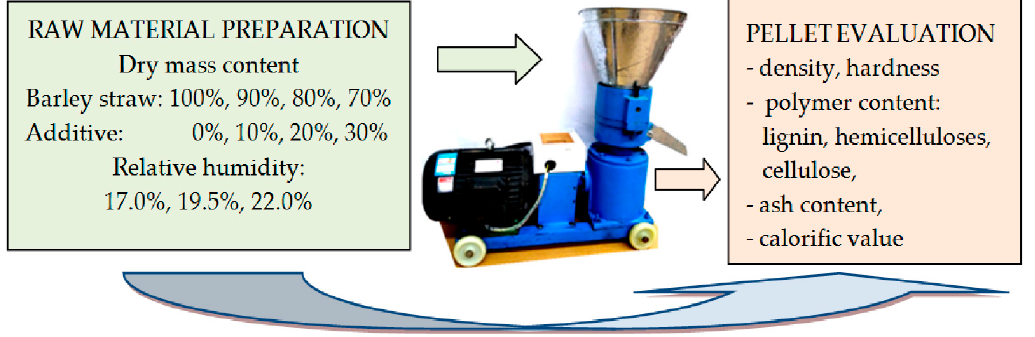
Figure 1. The diagram of research.